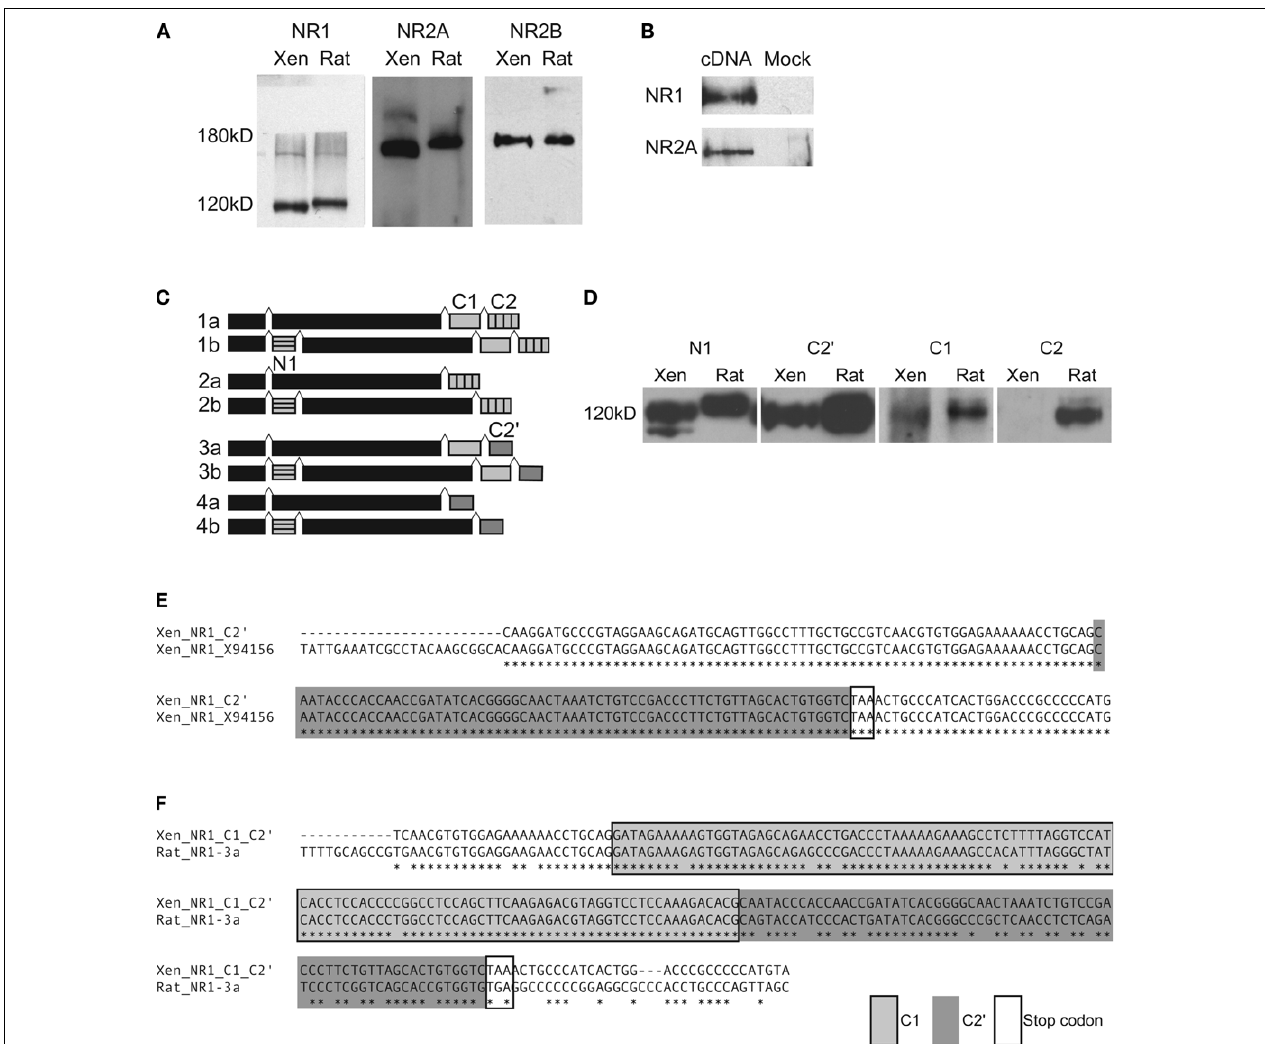
to rat homologs by Western blot on whole brain extracts from stage 47/48 tadpoles and rat. No cross-reactive band was detected for C2. (E,F) C-terminal ends of NR1 mRNAs were amplifi ed by RT-PCR and PCR with primer pairs 5 ′ to the spliced region and in the 3 ′ UTR. (E) Twenty-six out of 29 nucleotide sequences contained only C2 ′ (Xen_NR1_C2 ′ ). They aligned perfectly to the published X. laevis NR1 sequence (Xen_NR1_X94156). (F) Two out of